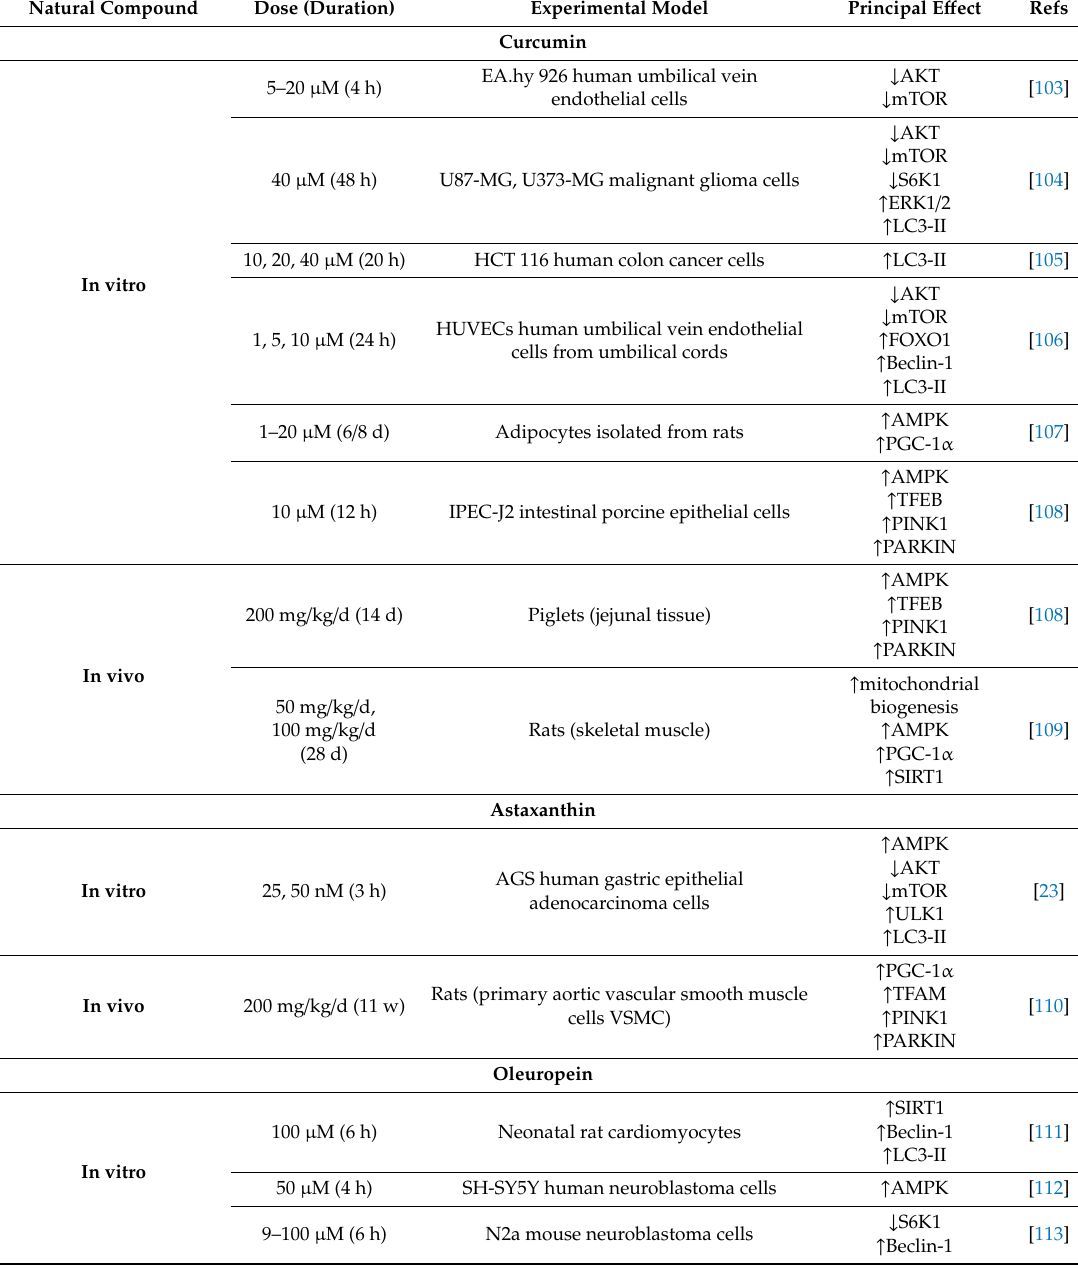
Table 1. Mechanisms of bioactive food compounds in